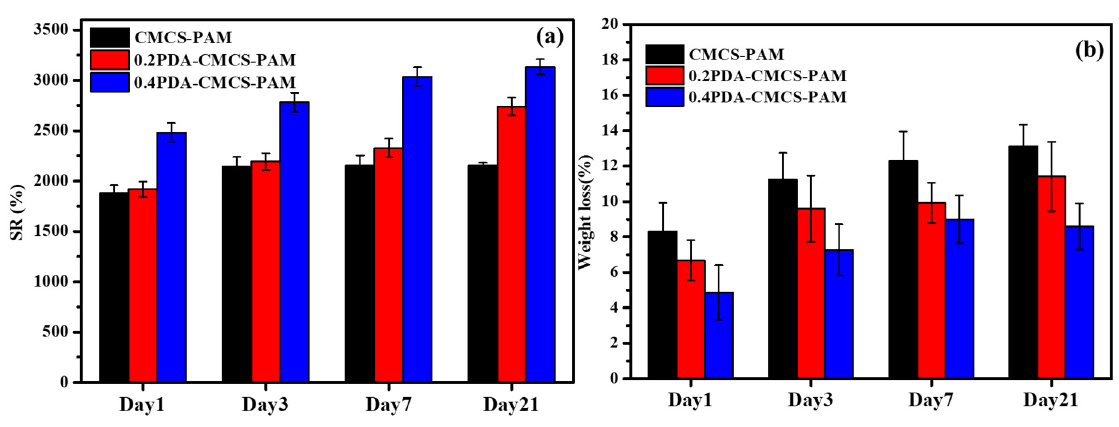
Figure 7. ( a ) Swelling and ( b ) biodegradation of